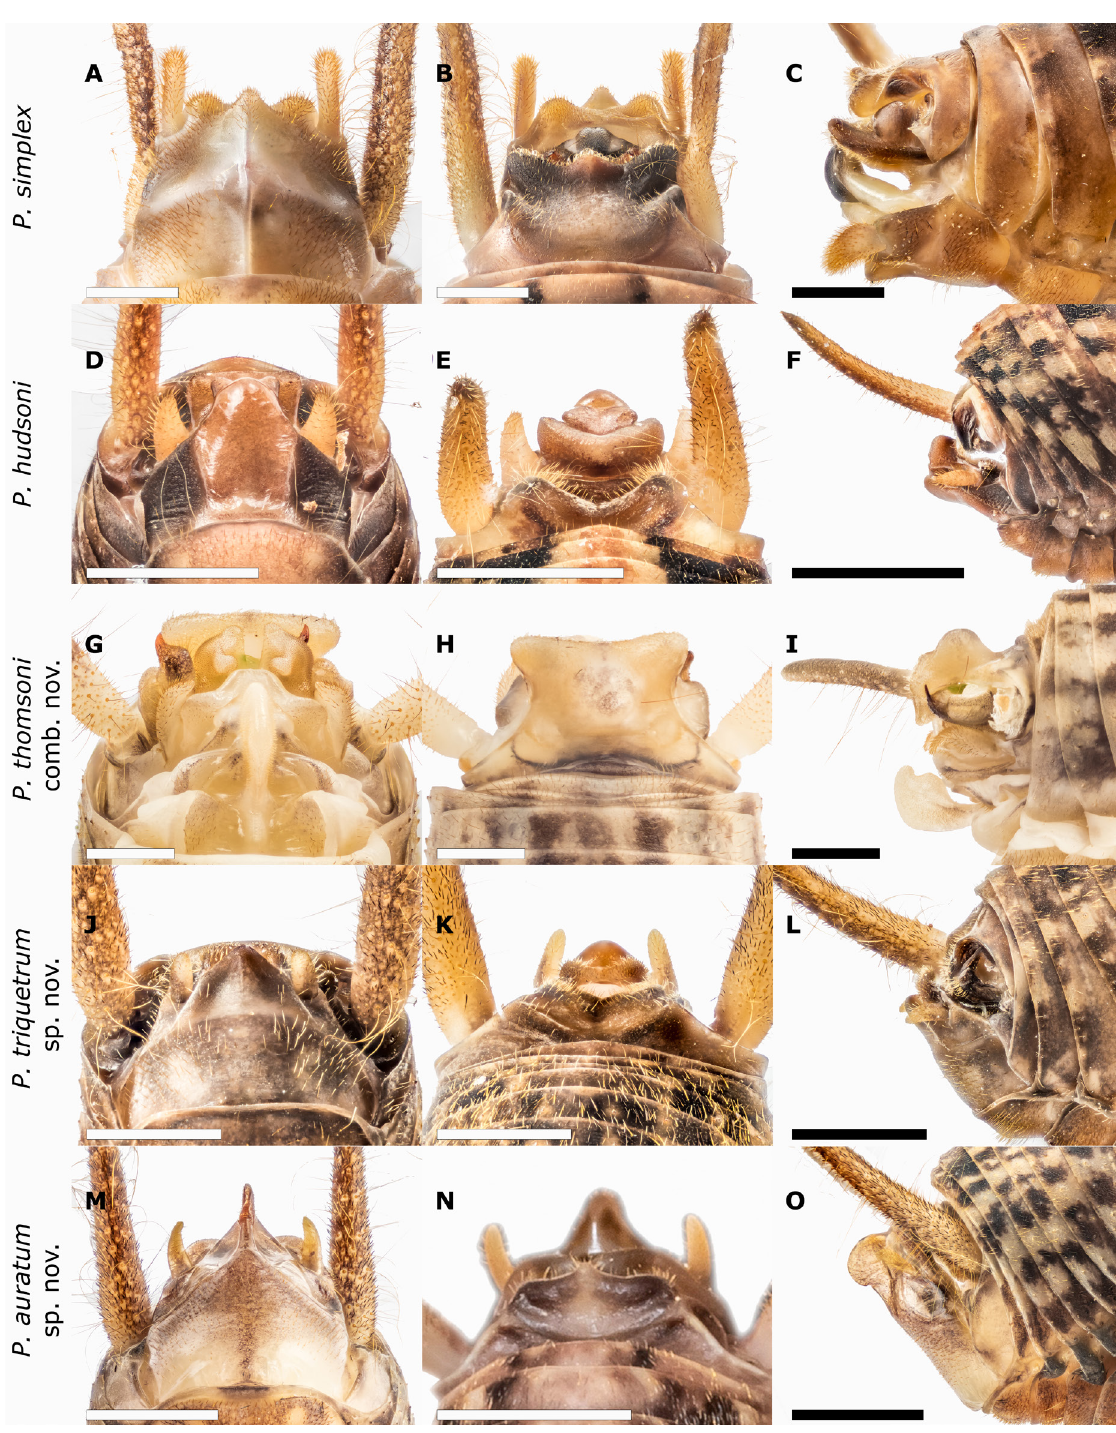
Fig. 8. Adult male terminalia of cave wētā in the genus Pleioplectron Hutton, 1896. Left column: ventral view (subgenital plate); central column: dorsal view; right column: lateral view. A–C . P. simplex